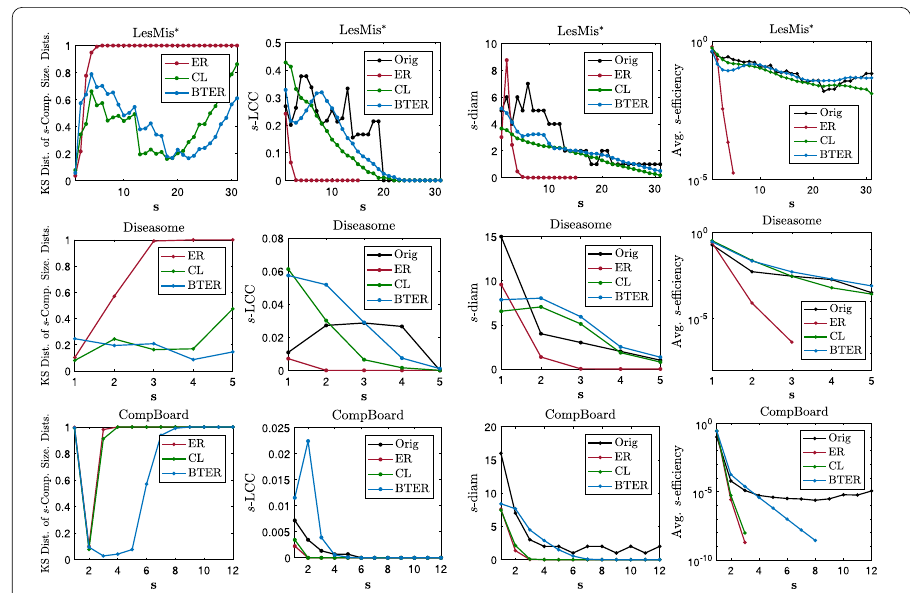
Figure 9 Comparison of s -component size distributions, mean s -local clustering coefficients, s -diameter, and average s -efficiency of the LesMis * , Diseasome, and CompBoard datasets against those of hypergraphs synthetically generated by ER, CL, and